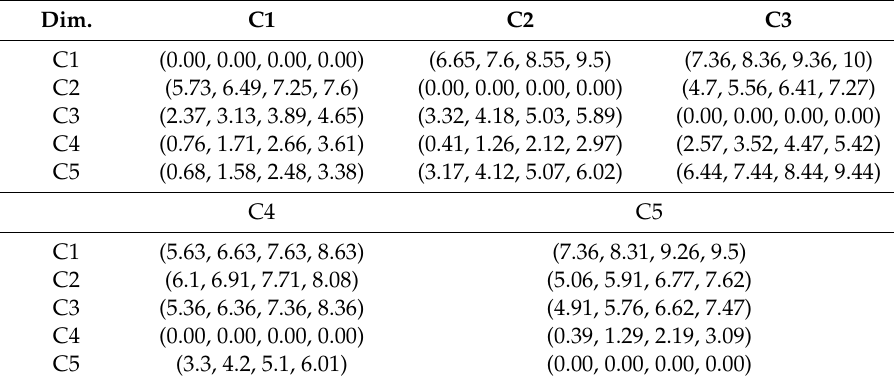
Table 5. Single fuzzy direct-relation